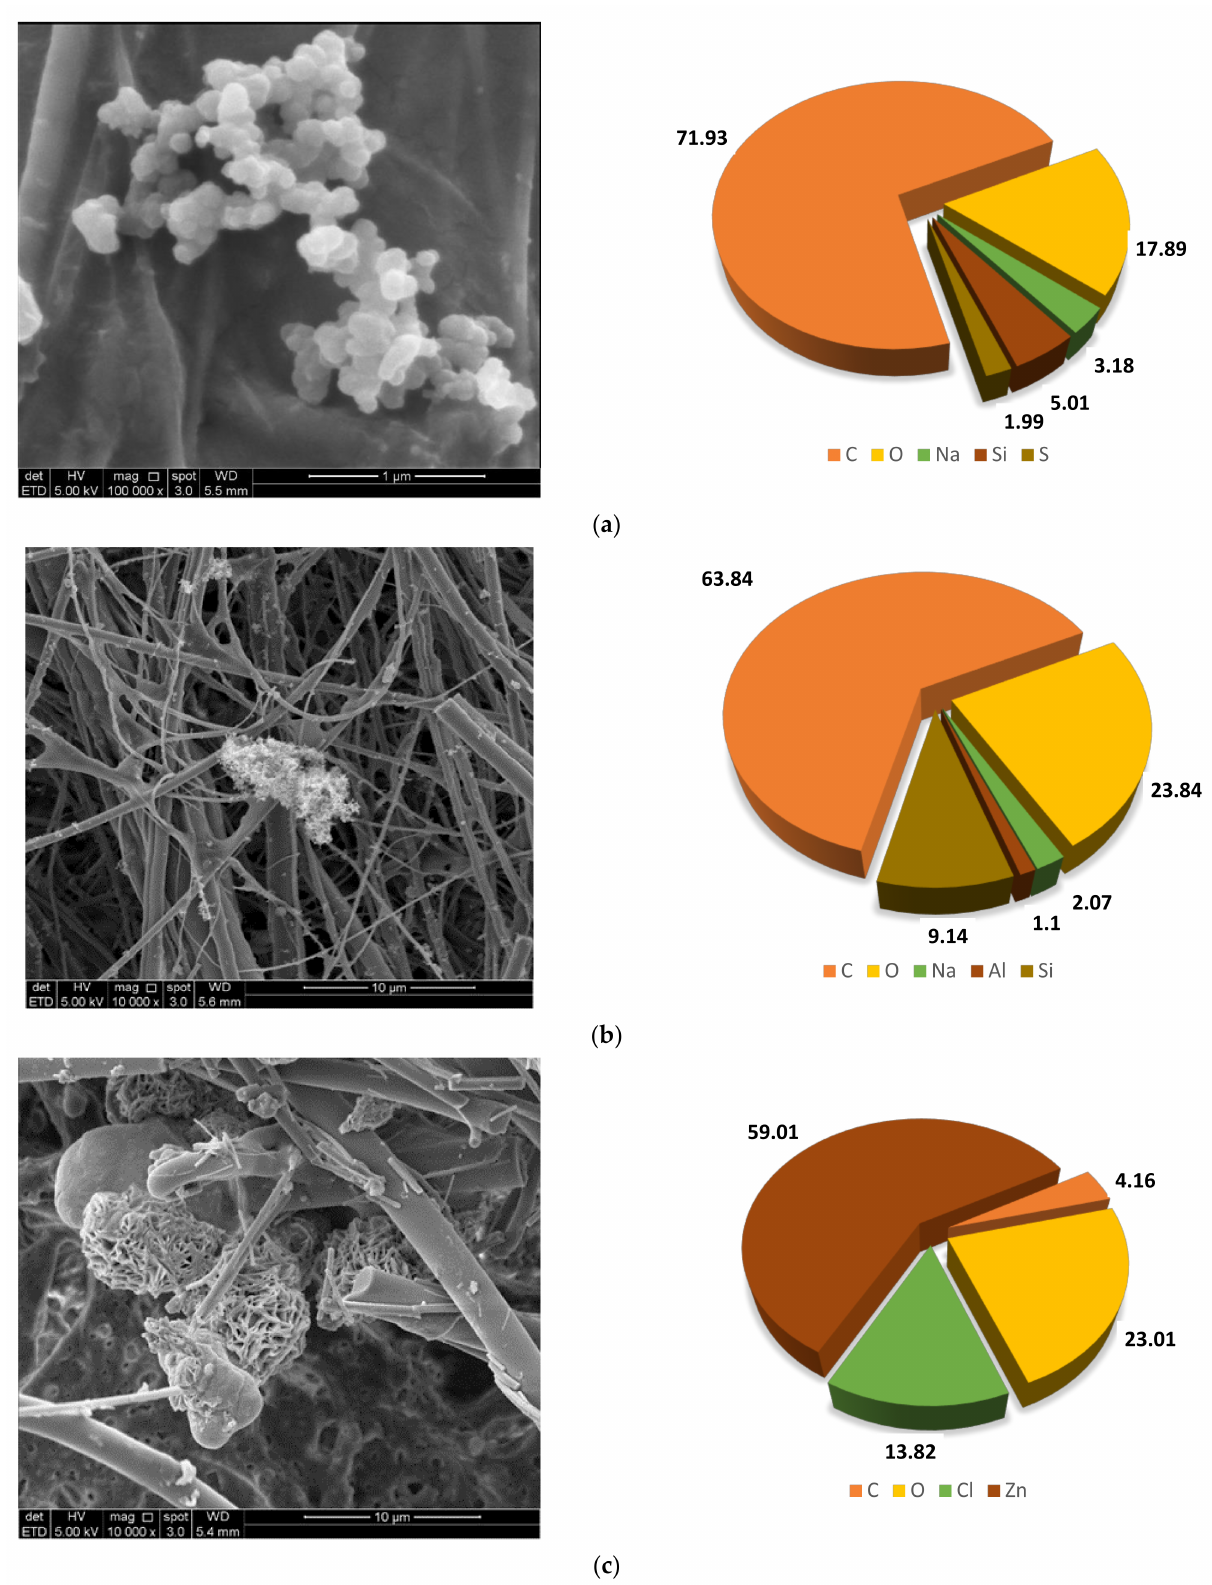
Figure 9. ( a ) Natural particles; ( b ) anthropogenic particles; ( c ) major zinc element in PM2.5